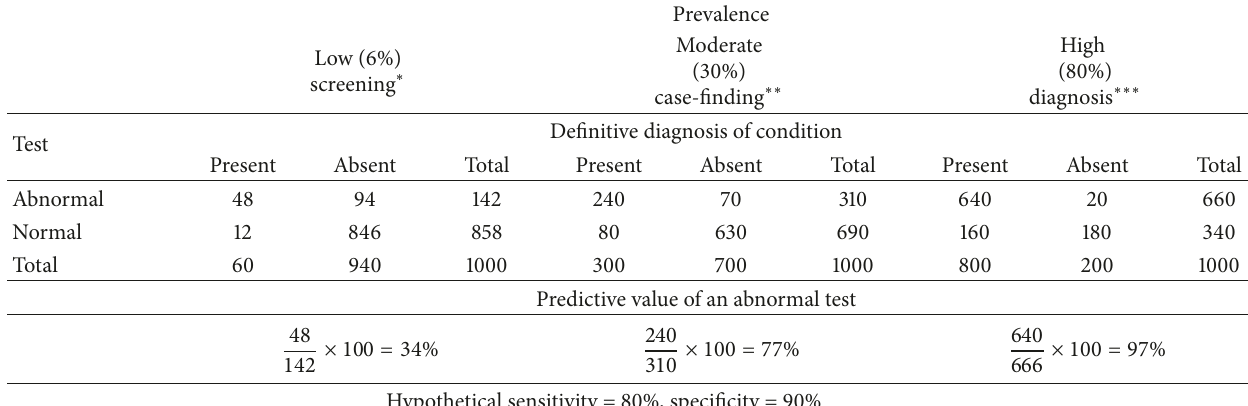
Table 2: The effect of prevalence on the predictive value of a screening